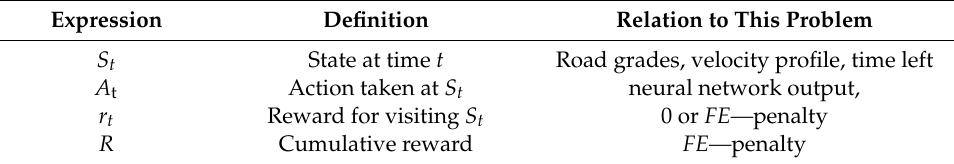
Table 2. Reinforcement learning terminologies and